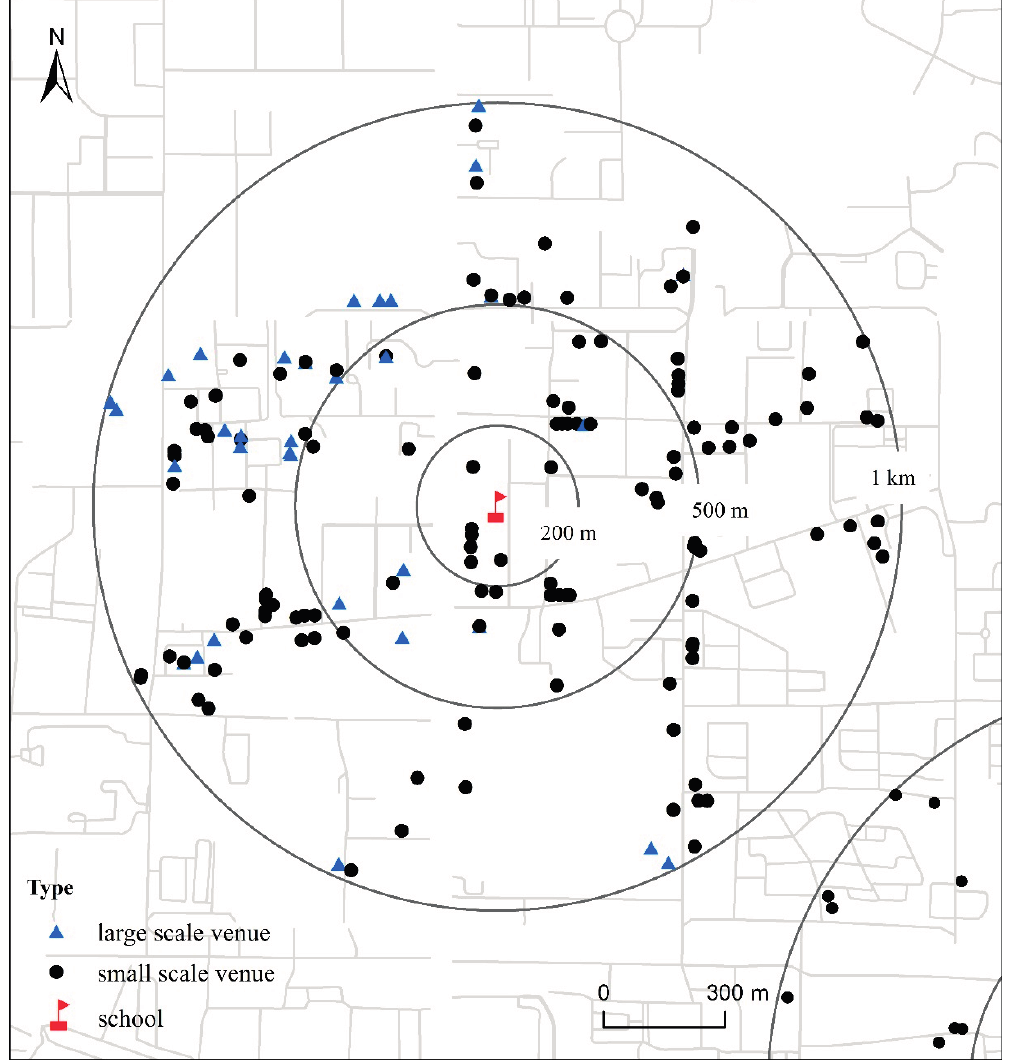
Figure 2. The distribution of catering service venues and different distance buffer for one